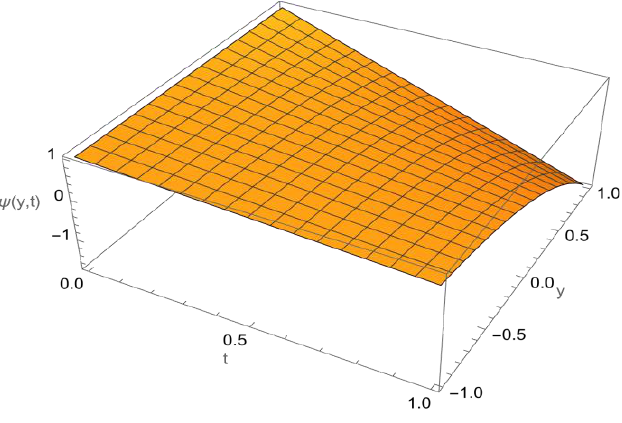
Figure 2. Exact solution ψ ( y , t ) of Example 2.